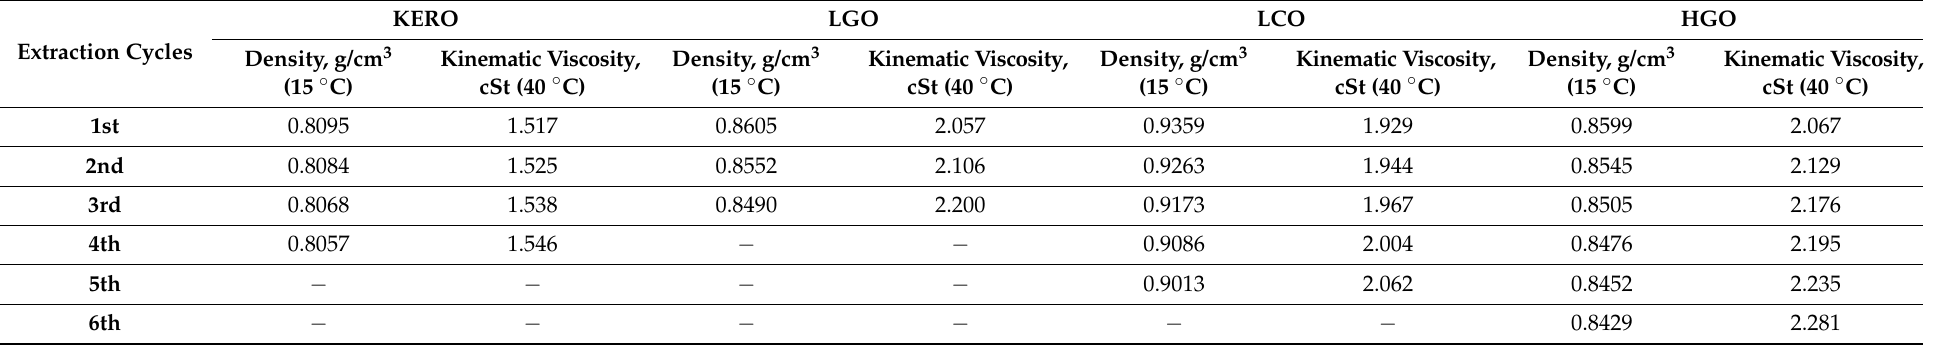
Table 11. Density and kinematic viscosity of the surrogate raffinates during the multiple-stage extractions with recycled